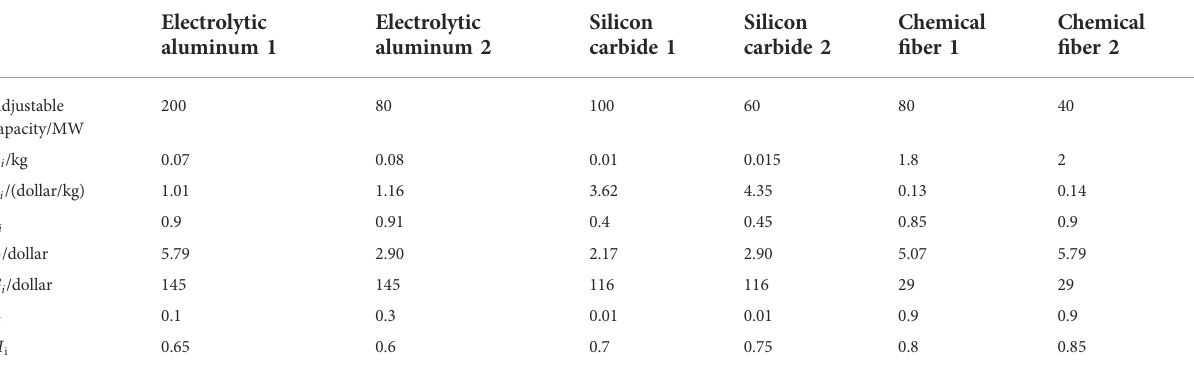
TABLE 1 Regulation information of controllable loads.